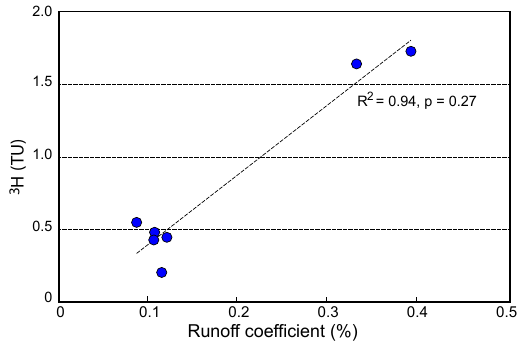
Figure 10. 3 H activities vs. runoff coefficients for the March 2015 samples (data from Table 1 and Supplement). Although a strong correlation ( R 2 = 0 . 94) exists, it may be a result of the grouping of the samples.